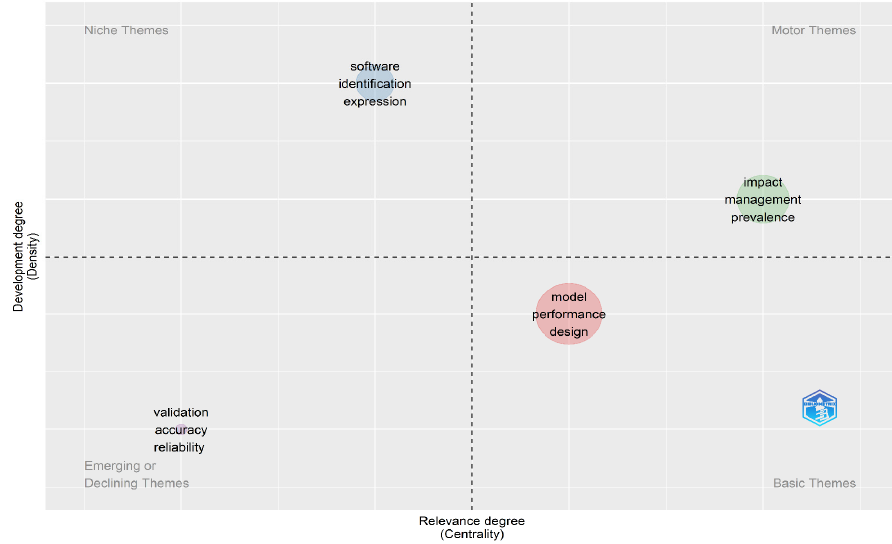
Figure 17. Thematic Map for the years 2019–2021.